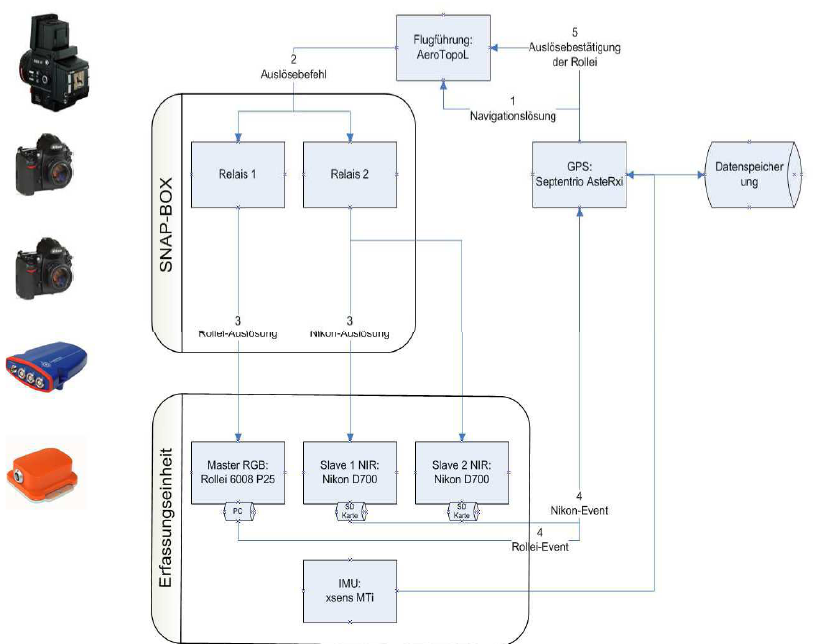
Figure 13 : Integration scheme of the technical components of